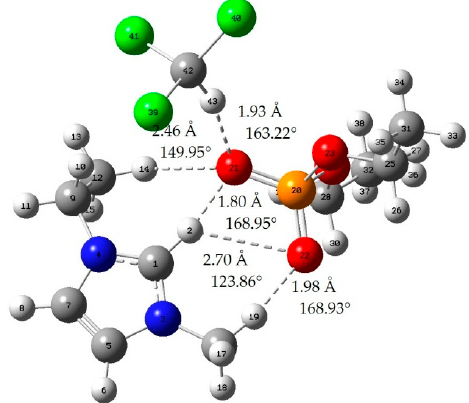
Figure A4. Chloroform-[MMIM][DMP]; red: oxygen atom; green: chlorine atom gray: carbon atom; white: hydrogen atom; blue: nitrogen atom; dotted line: hydrogen bond.